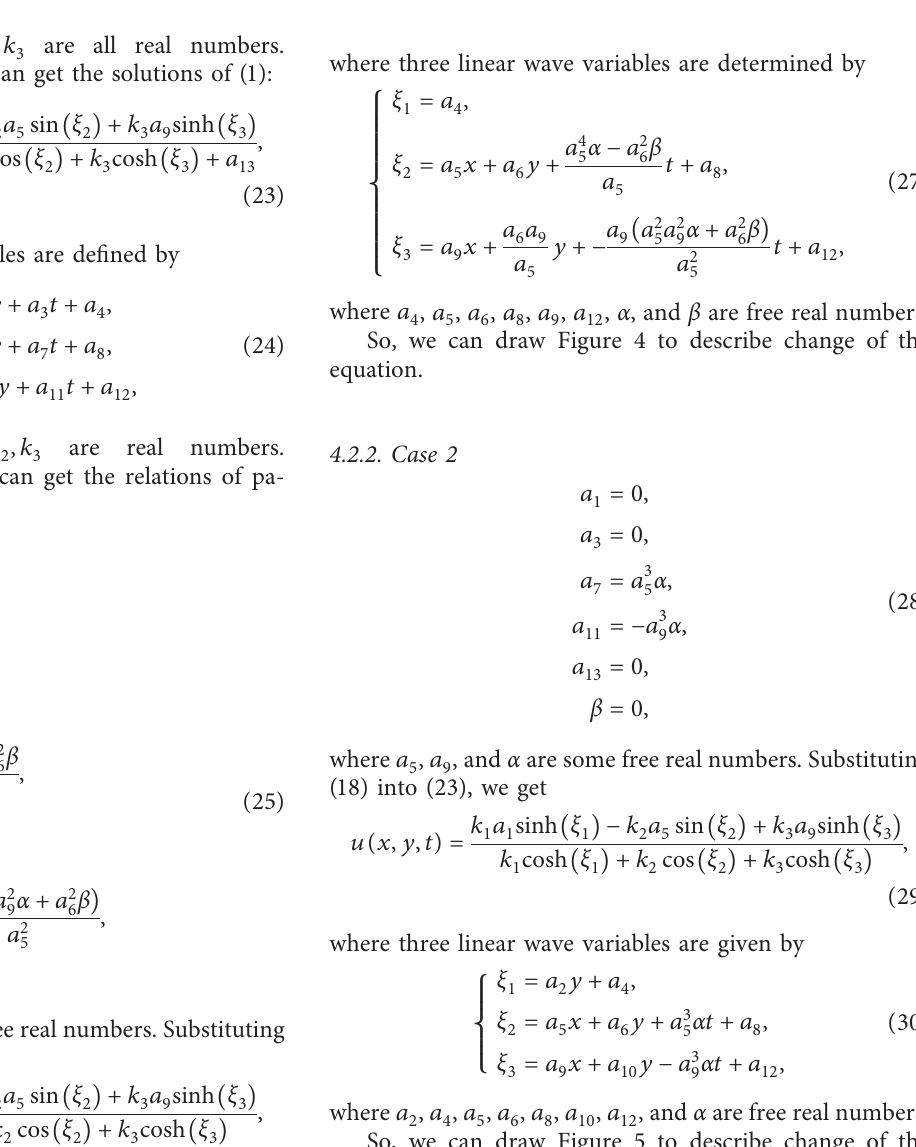
Figure 3: Spatiotemporal structure of solution (19) with parameter � 1, a � 1, and α � selections: a 5 9